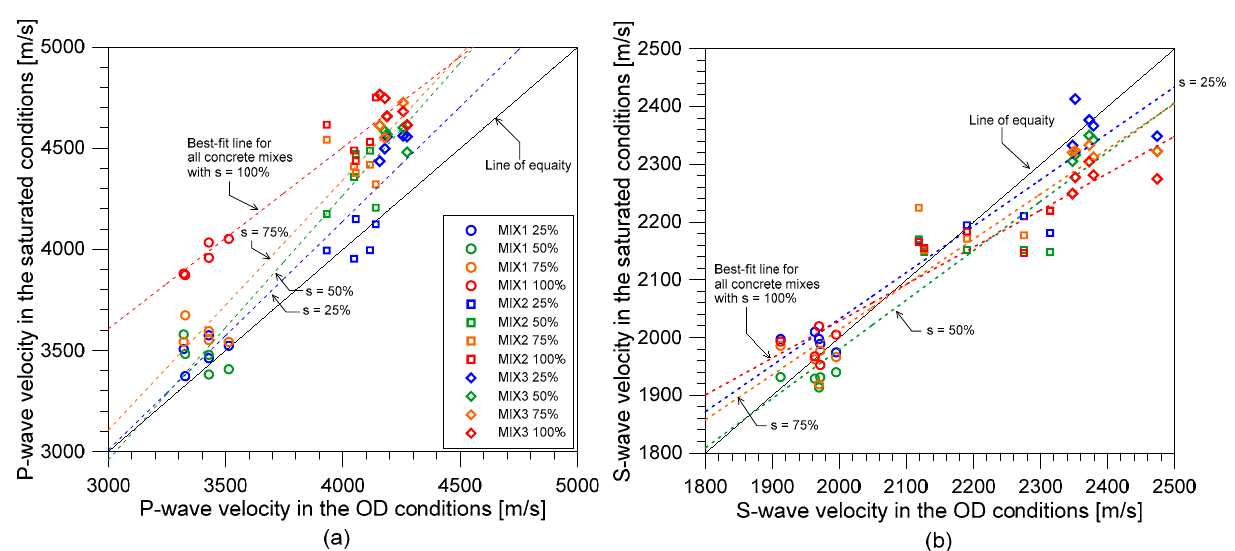
Figure 10. Relationship of stress wave velocities of the fully dry concrete and the saturated concrete for ( a ) P-wave velocities and ( b ) S-wave velocities.